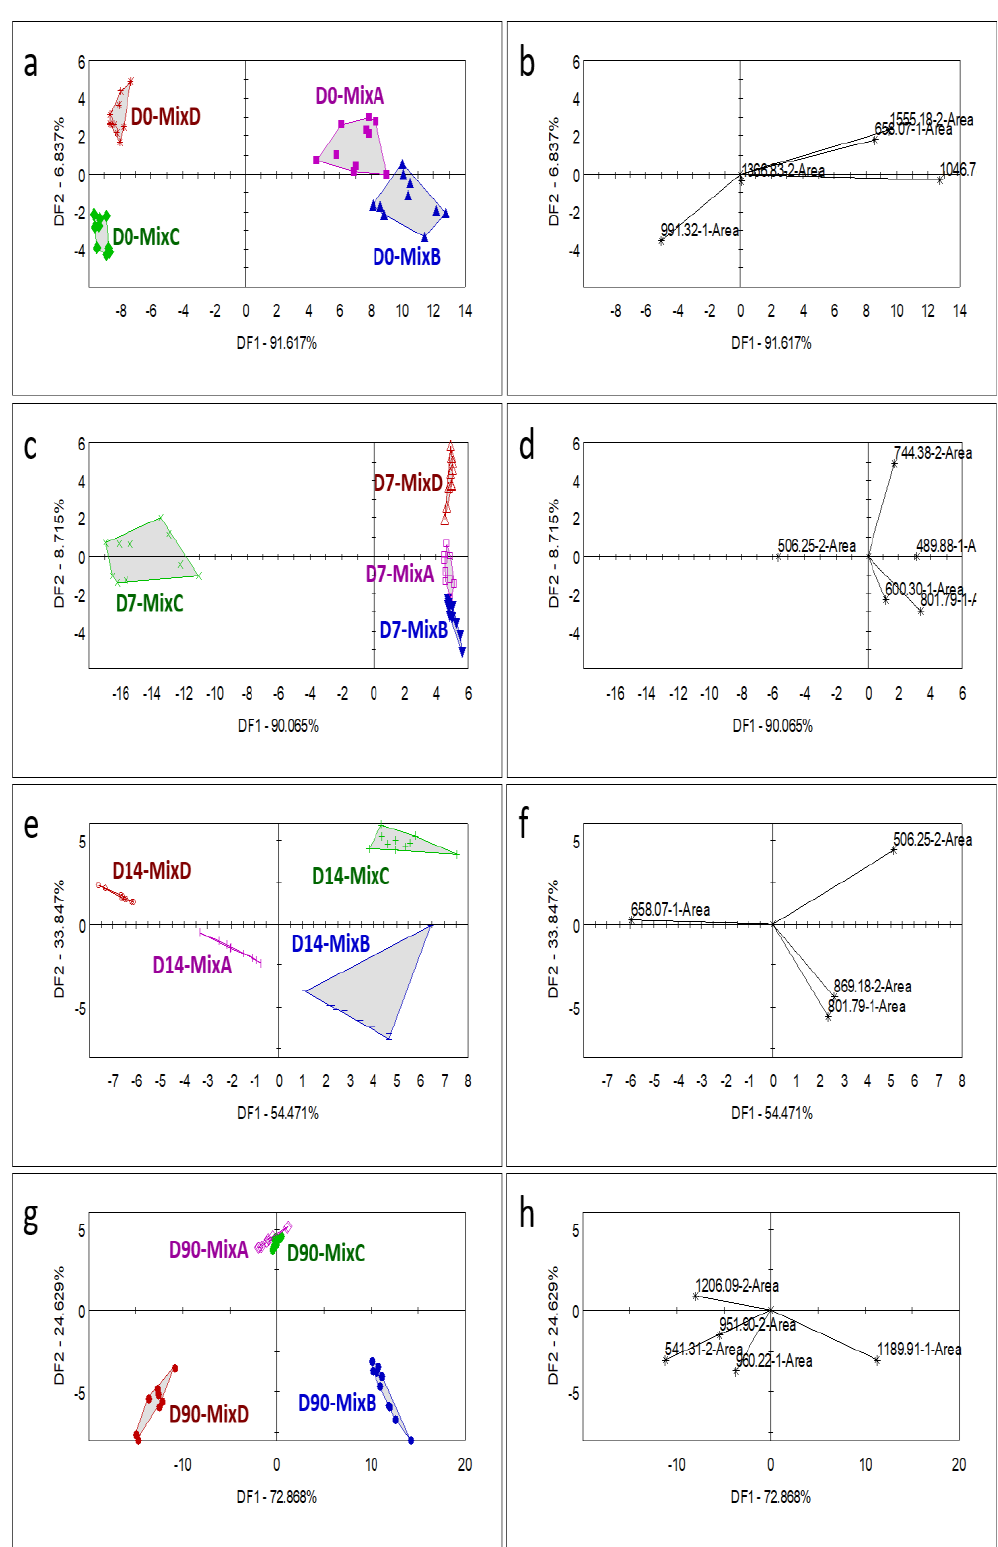
Figure 6. List discriminant analysis (LDA) classifications of the types of silages (mixture A, B, C and D) at the different fermentation stages ( a ): Day 0; ( c ): Day 7; ( e ): Day 14; ( g ): Day 90, and the loading plots ( b , d , f , h ) showing the impact of the selected dominant sensors on the relevant discriminant factors.